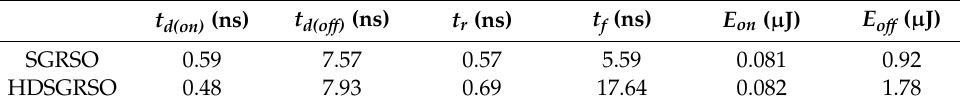
Table 2. Switching time and switching energy loss of two